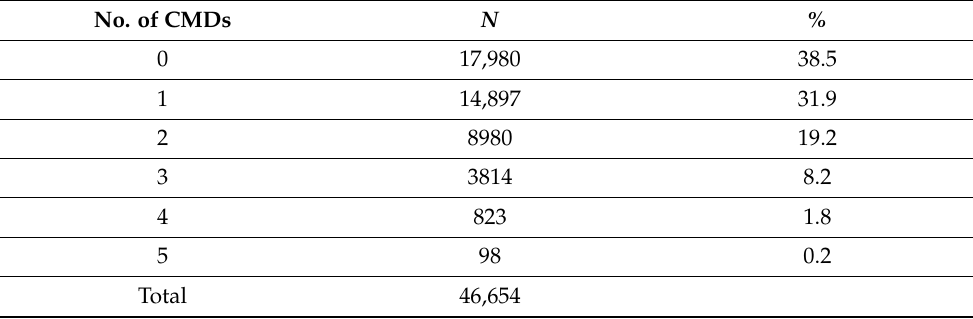
Table A2. Frequency and percentage of incidence of Cardio Metabolic Diseases.